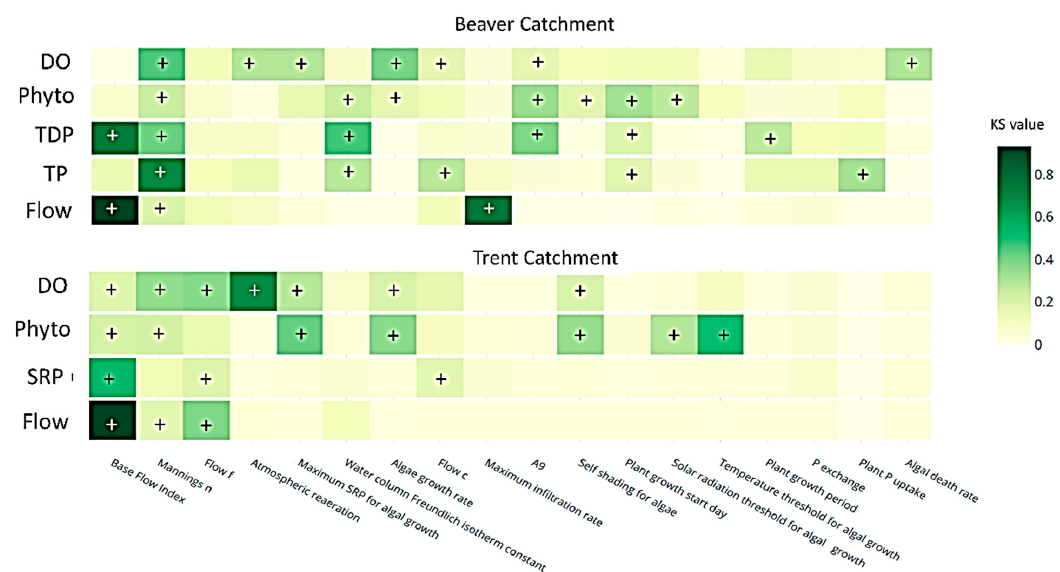
Figure 4. A sensitivity heat map for the Beaver and Trent model applications, using Kolmogorov–Smirnov (KS) values to indicate sensitivity of model performance to parameter variance.